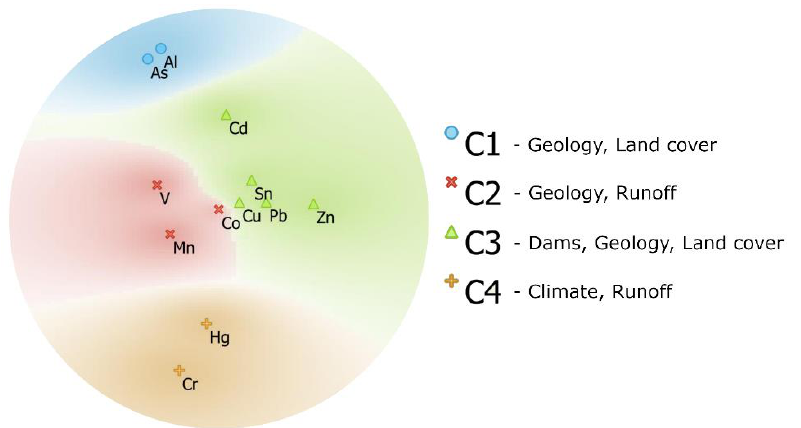
Figure 3. Display of the multidimensional space. The number of MIV per F.G. defines the position of each metal. The background colors indicate the area belonging to the respective clusters. The symbols of the individual points indicate allocation to one of the four meta groups (clusters) C1 – C4.